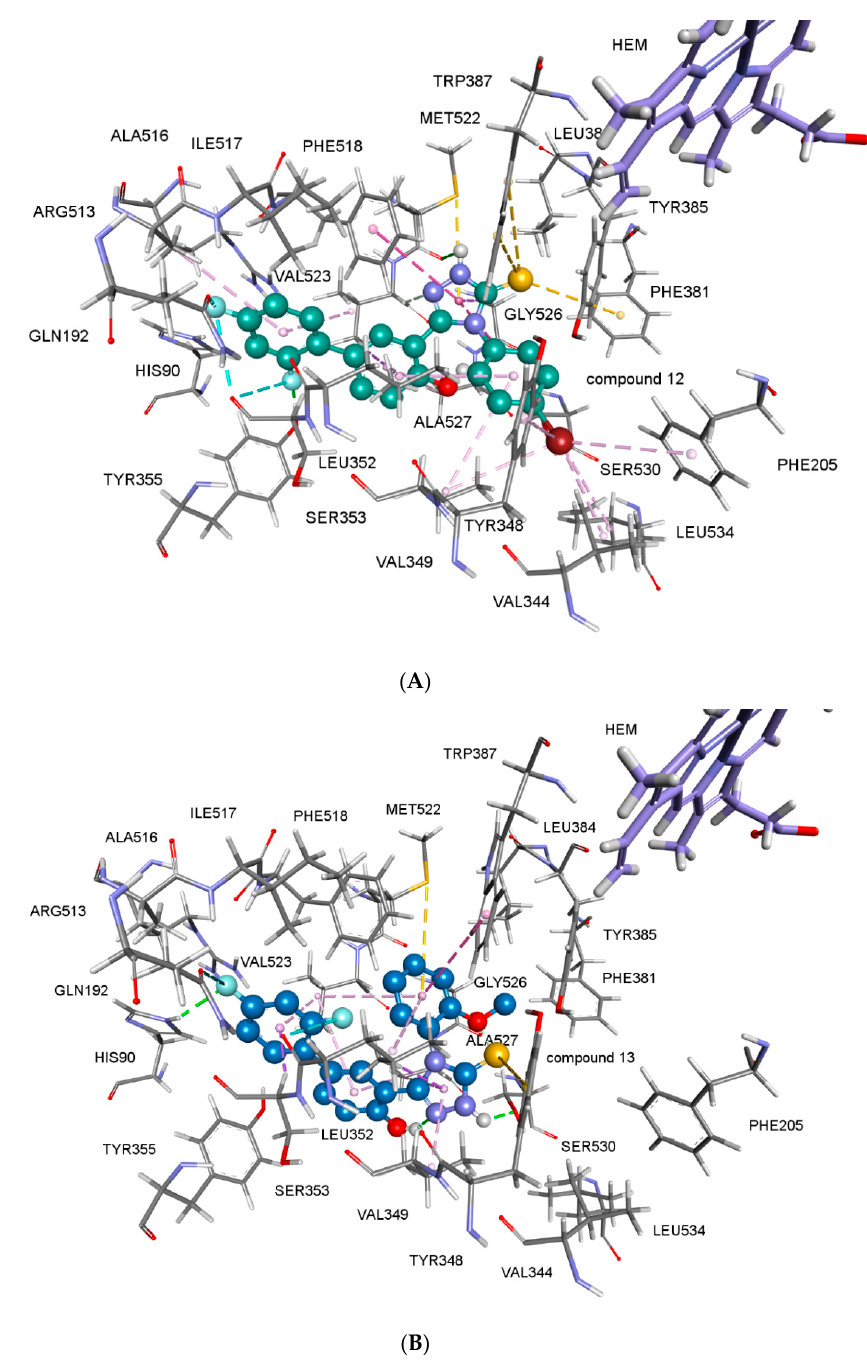
Figure 5. 3D representations of the predicted binding mode and protein-ligand interactions of compounds 15 ( A ) and 16 ( B ) for COX-2. Halogen interactions of fluoro substituents with LEU352 are shown in blue dashed lines; hydrophobic interactions of aromatic rings with side chains of Phe205, Val344, Tyr348, Phe381, Tyr355, Trp387, Ala527 and Leu534 are shown in pink. Two hydrogen bonds of compound 16 ( B ): HIS90 monocation with fluoro substituent, and the hydroxyl group of SER530 and the triazole ring are represented with green dashed lines. Yellow lines represent S/ π interactions of Met522 and with the aromatic rings of compounds. Compound 15 ( A ) showed one more S/ π interaction between the sulphur of the 1,2,4-triazole-3-thion ring with the aromatic ring of